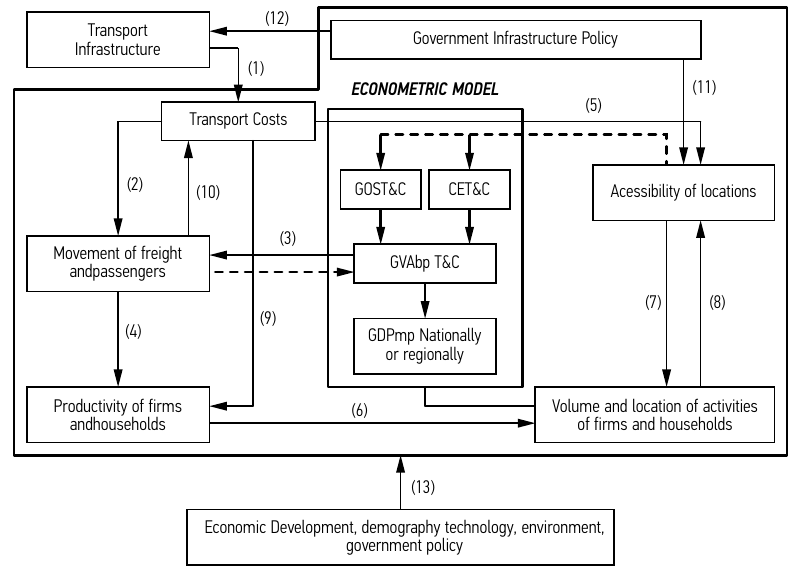
Fig. 4. Accessibility impact and macroeconomic variables to measure economic